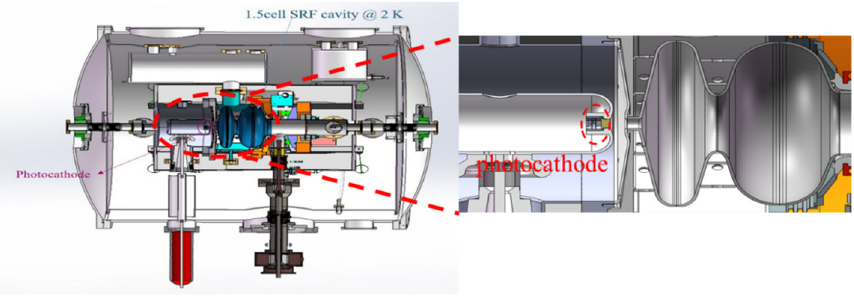
Figure 8. Design of DC ‐ SRF photoinjector II. The photocathode is installed in the DC structure